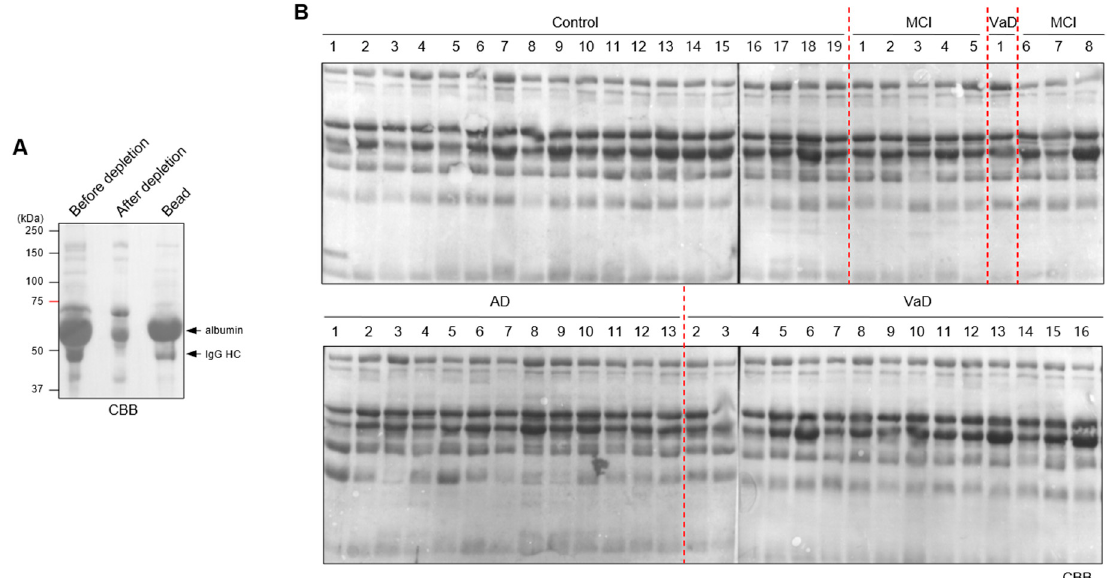
Figure 1. Preparation of patient plasma samples for SDS-PAGE analysis. ( A ) Plasma samples for SDS-PAGE analysis were prepared by depletion of affinity-purified albumin and immunoglobulin G (IgG) from the plasma. ( B ) Preparation of albumin/IgG-depleted control and patient plasma samples was verified by SDS-PAGE. CBB, Coomassie Brilliant Blue. HC, heavy chain. AD, Alzheimer’s disease; MCI, mild cognitive impairment; VaD, vascular dementia. Molecular weight standards (in kDa) are shown to the left.